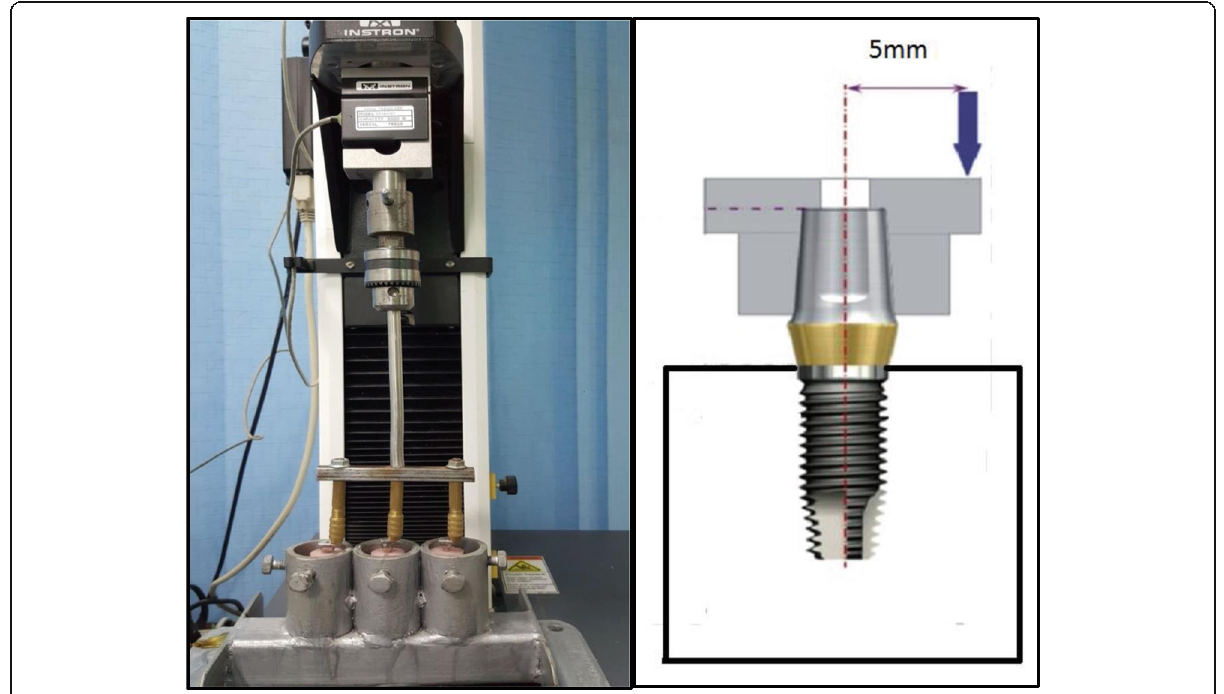
Fig. 2 Universal testing machine with samples under dynamic cyclic loading and schematic diagram for testing